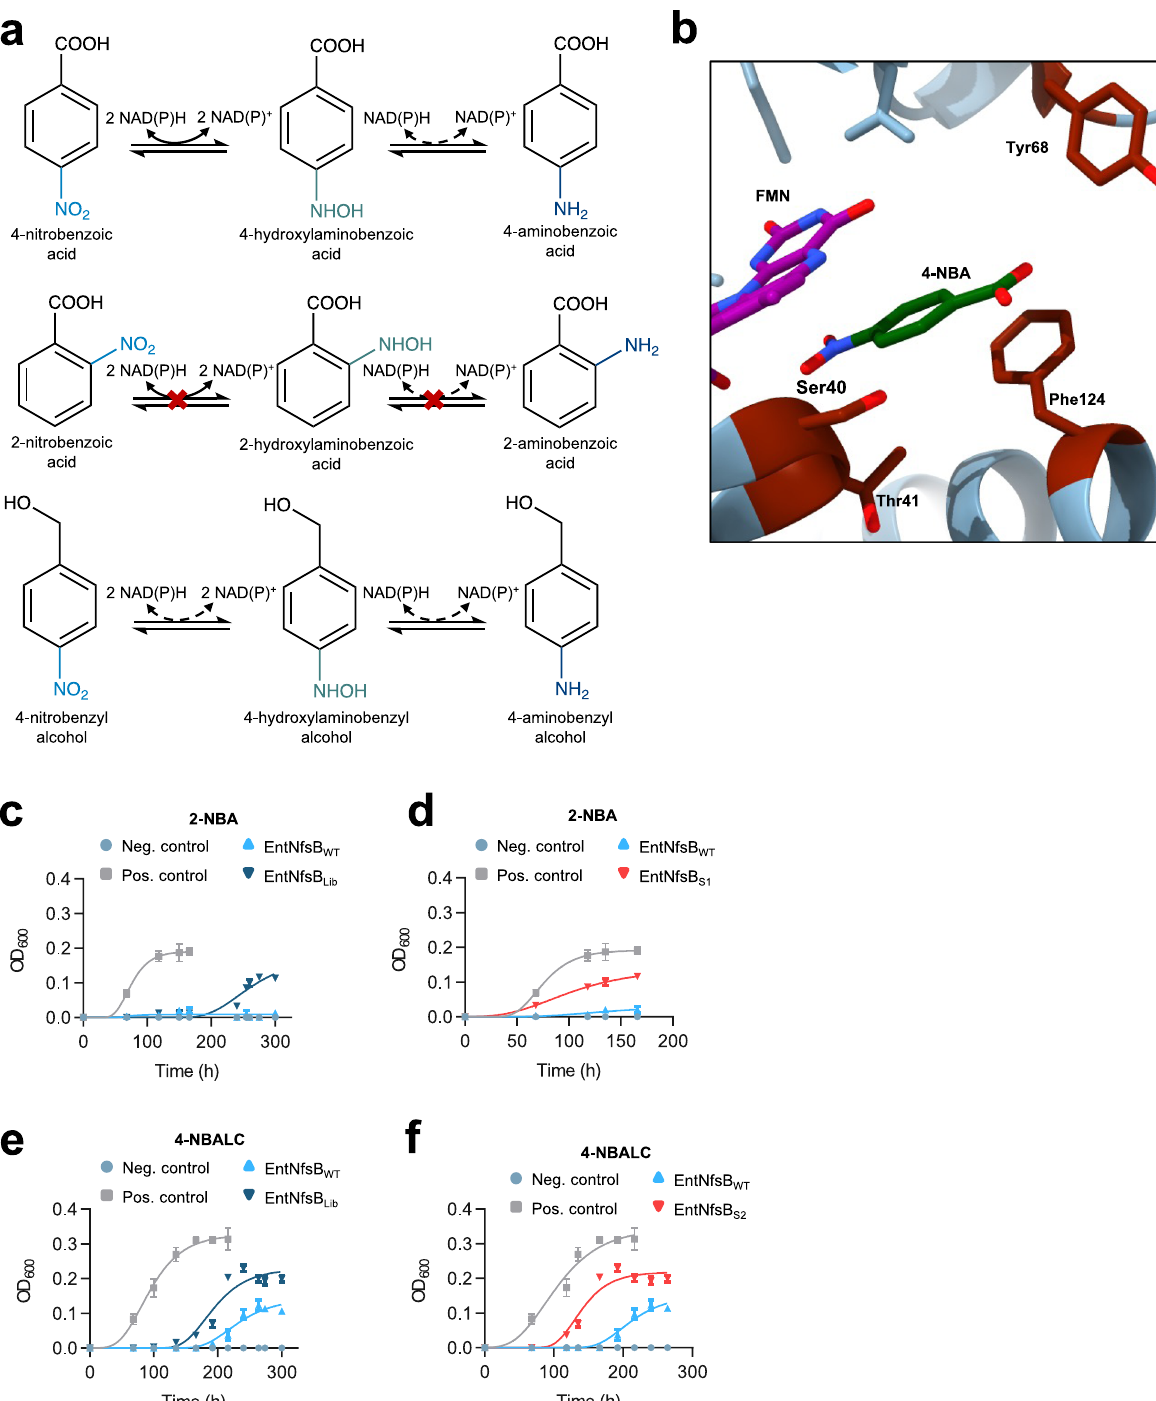
NATURE COMMUNICATIONS| (2021) 12:6859